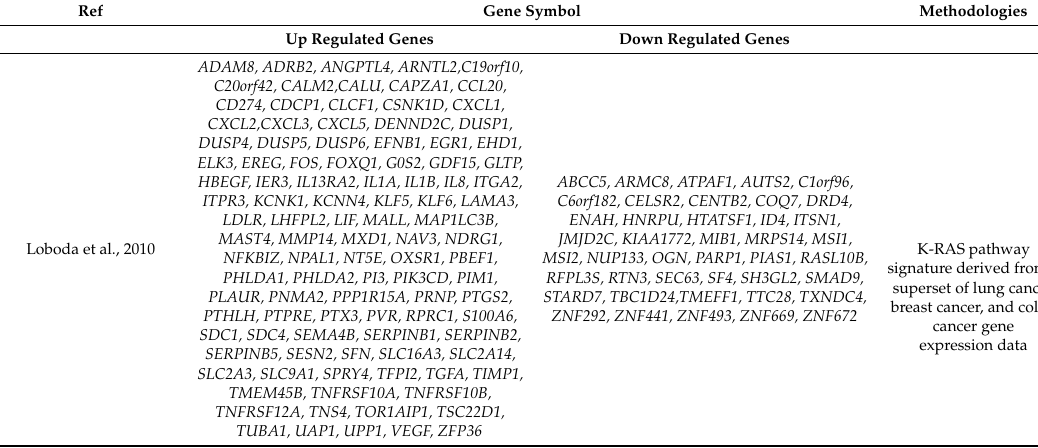
Table 1. Listing of upregulated and downregulated genes related to K-RAS pathway activation [45] and to K-RAS dependency